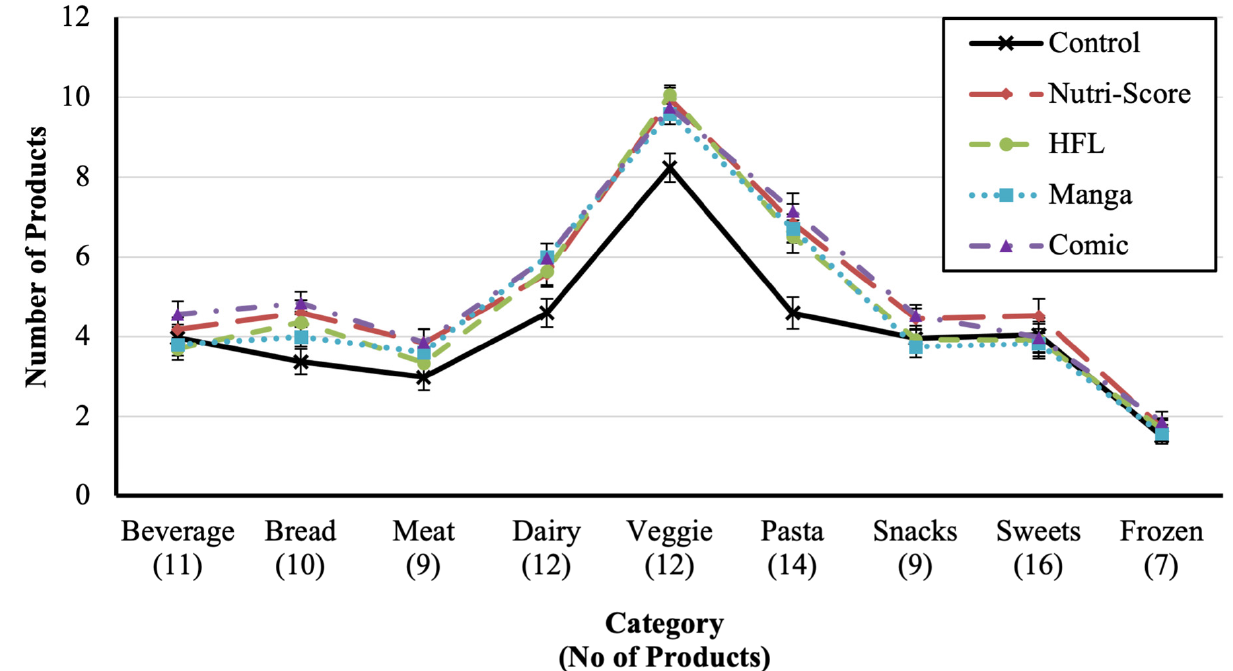
Figure 3. Number of products bought per category.